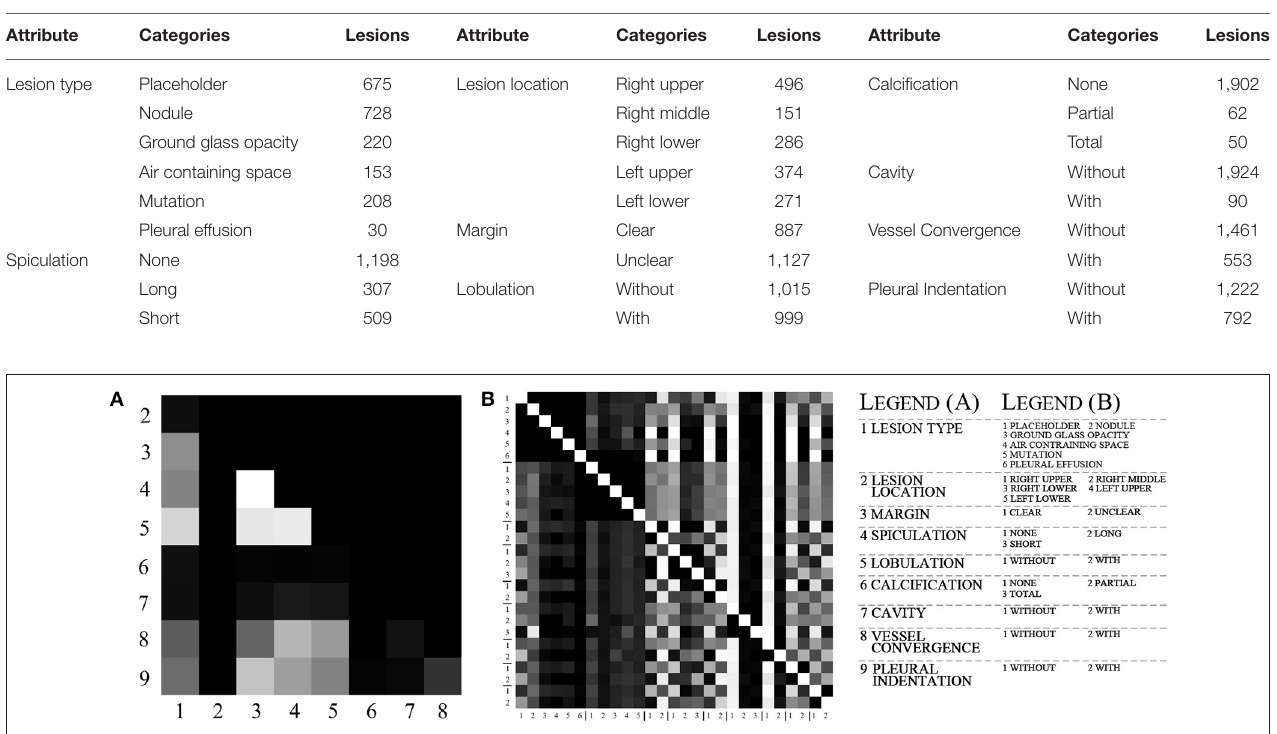
TABLE 2 | The distribution of each attribute category used for experiments.